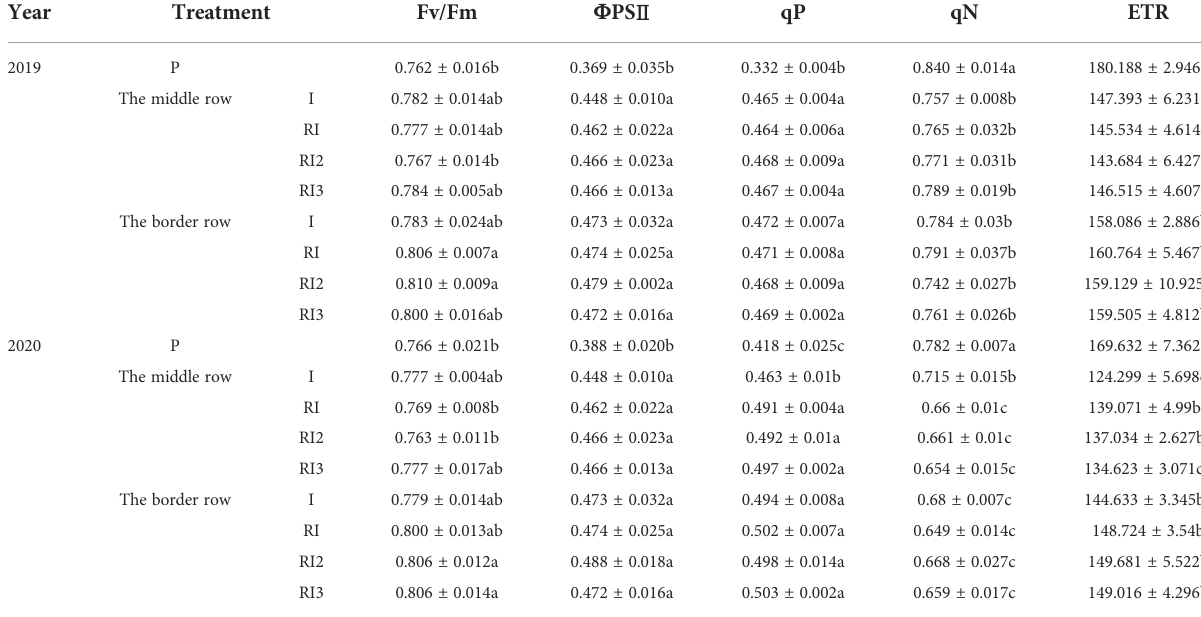
TABLE 2 The chlorophyll fl uorescence characteristics of peanut.